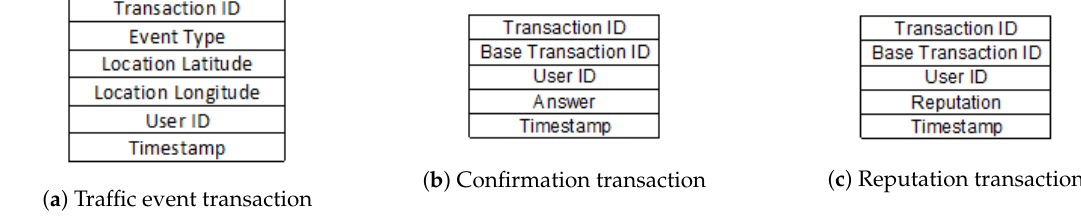
Figure 8. Visual representations of the transaction for traffic event, confirmation and